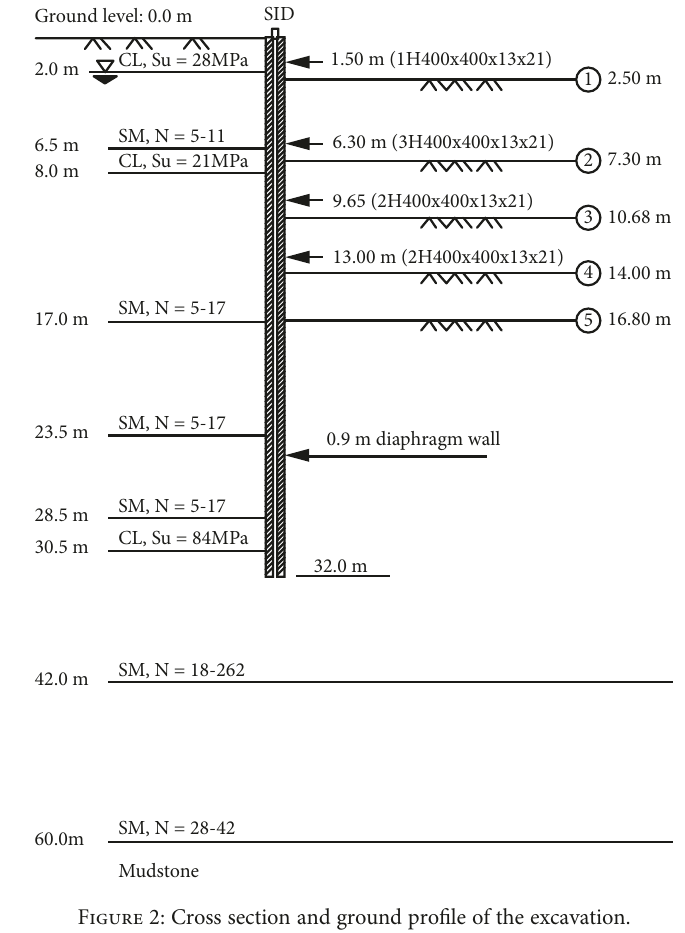
Figure 2: Cross section and ground pro fi le of the excavation.